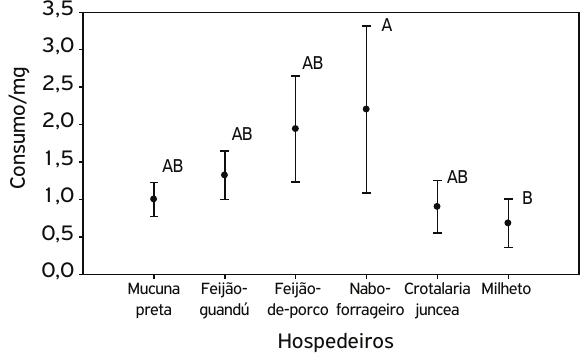
Figura 1. Médias ( ± EPM) da massa seca consumida (mg) por Spodoptera eridania em diferentes